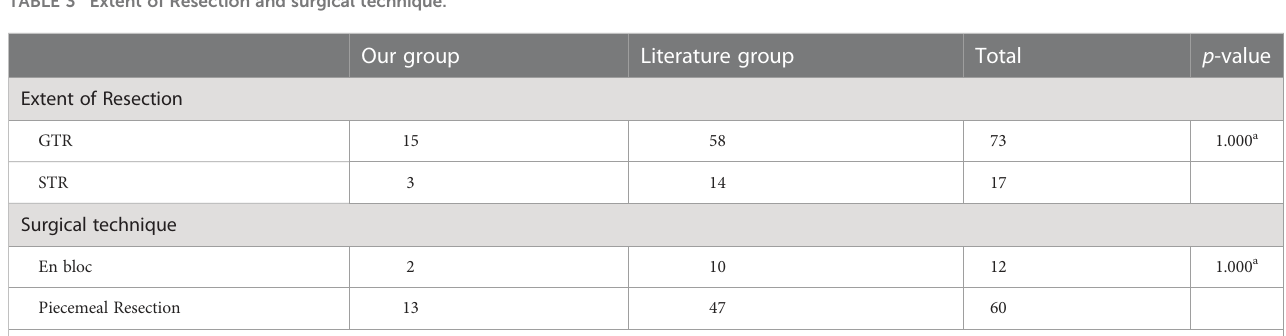
TABLE 3 Extent of Resection and surgical